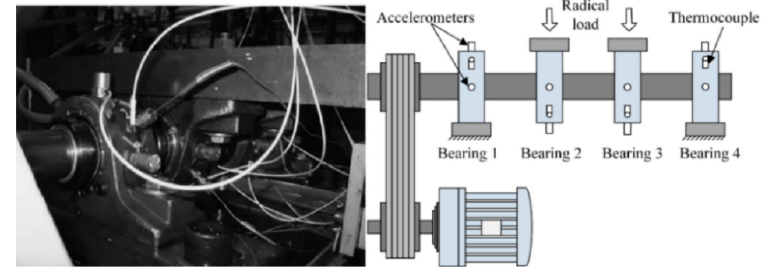
Figure 3. Experimental setup.